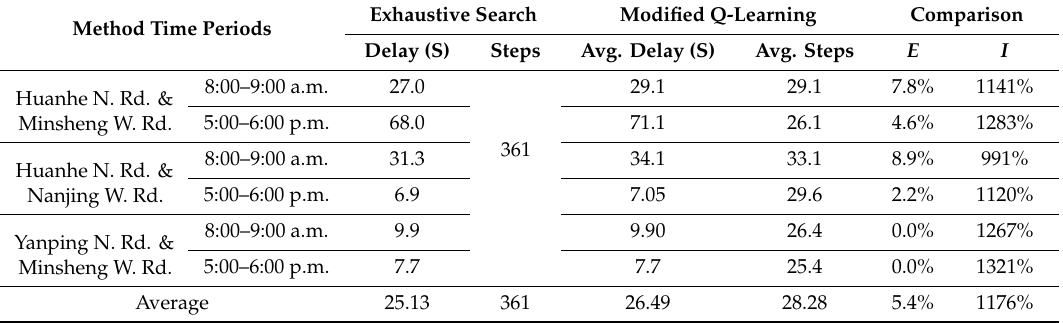
Table 2. The delay and processing steps for exhaustive search and modified Q-learning schemes. Exhaustive Search Modified Q-Learning Method Time Periods